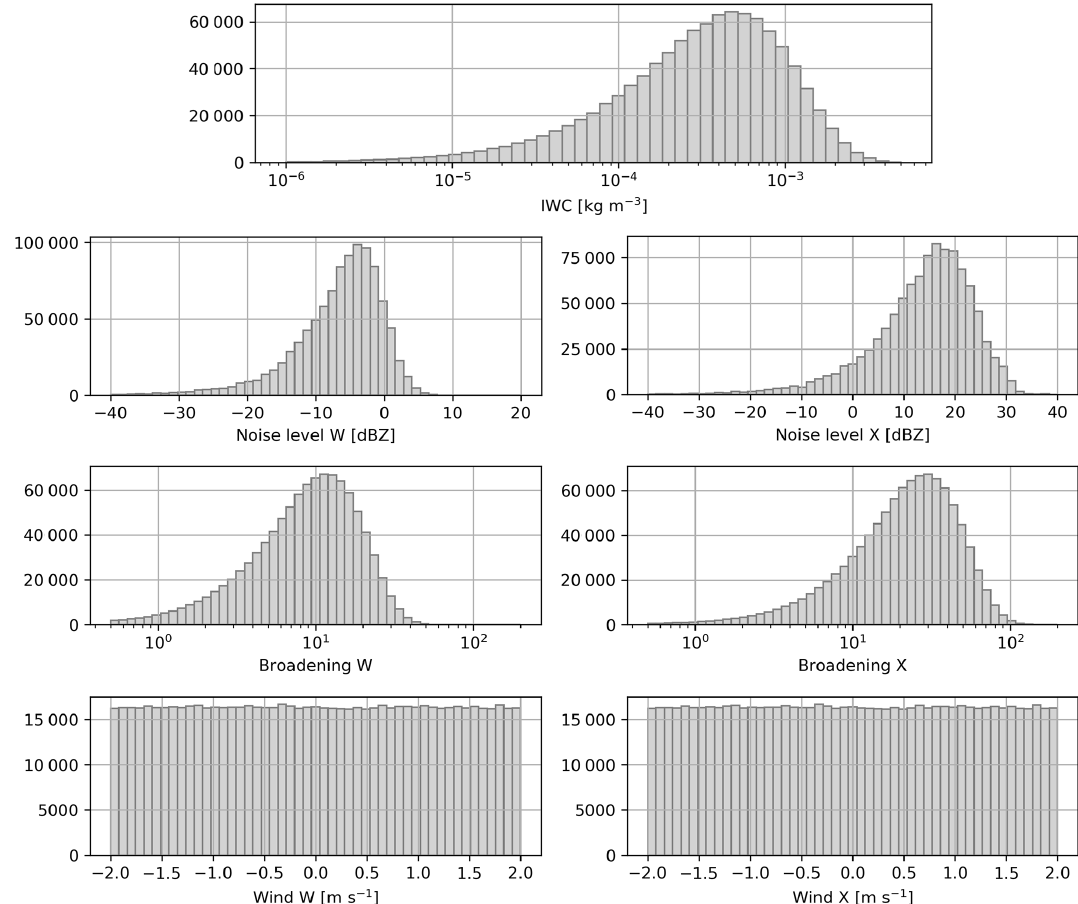
Figure B2. Same as Fig. B1 but for the other microphysical descriptors, which are not provided in MASCDB.